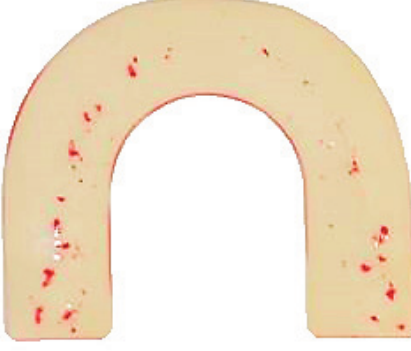
Fig. 1. Occlusal contacts registered on a prescale film.